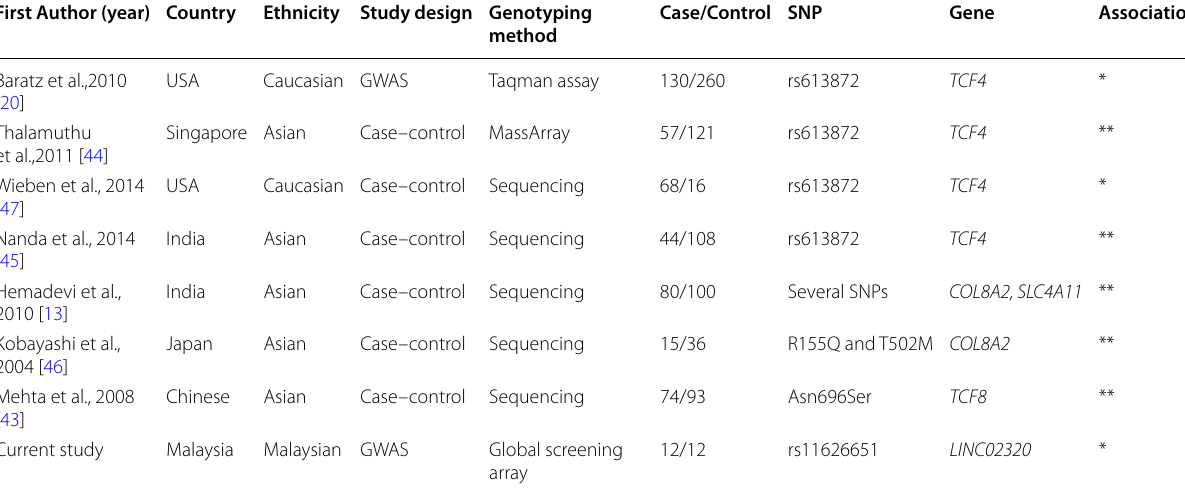
Table 4 Associations of candidate genes in various